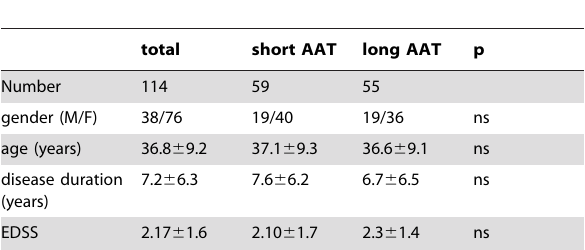
Table 1. Demographic and clinical characteristics of MS subjects.